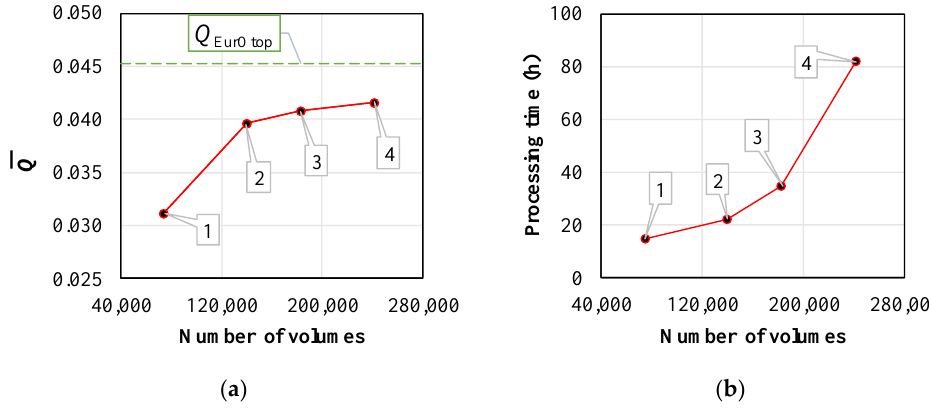
Figure 9. Mesh sensitivity test: ( a ) Q ̅ comparison with Q ̅ EurOtop and ( b ) Processing time. Furthermore, the uncertainly analyses Grid Convergence Index (GCI) [58,59] was used in meshes 2, 3, and 4. The refinement ratio estimate was calculated by: